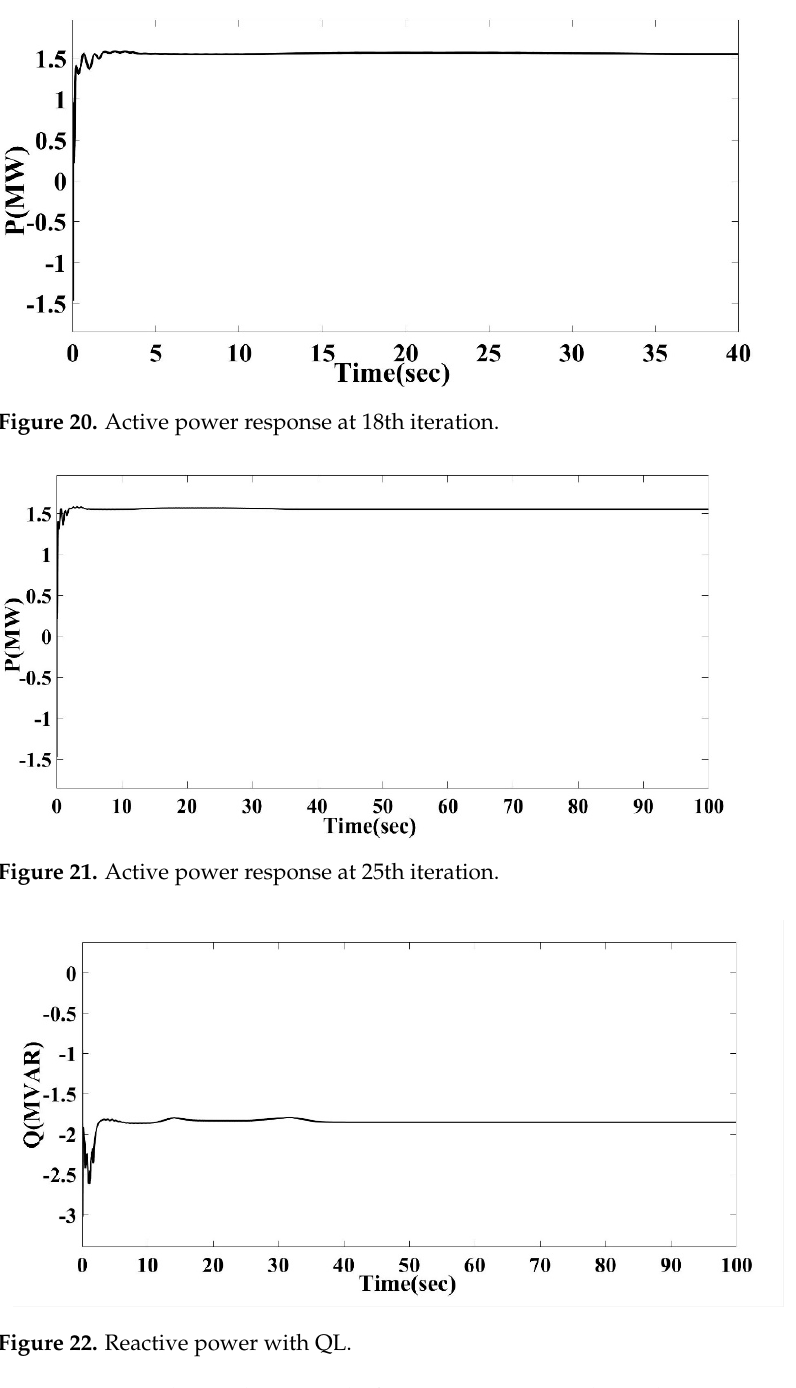
Figure 22. Reactive power with QL.